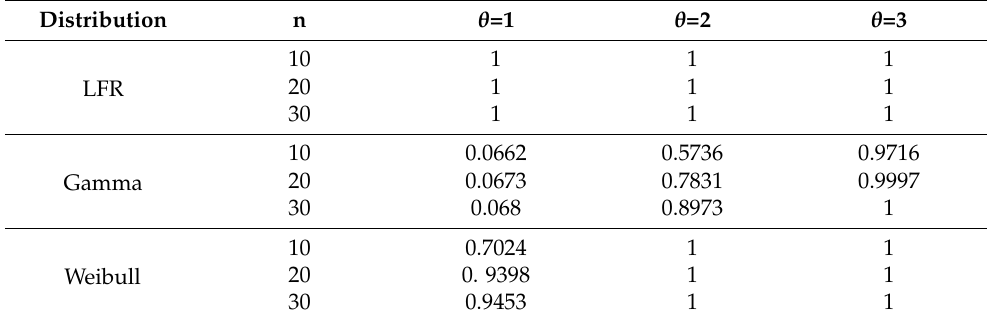
Table 3. Estimates of powers at α = 0.05.